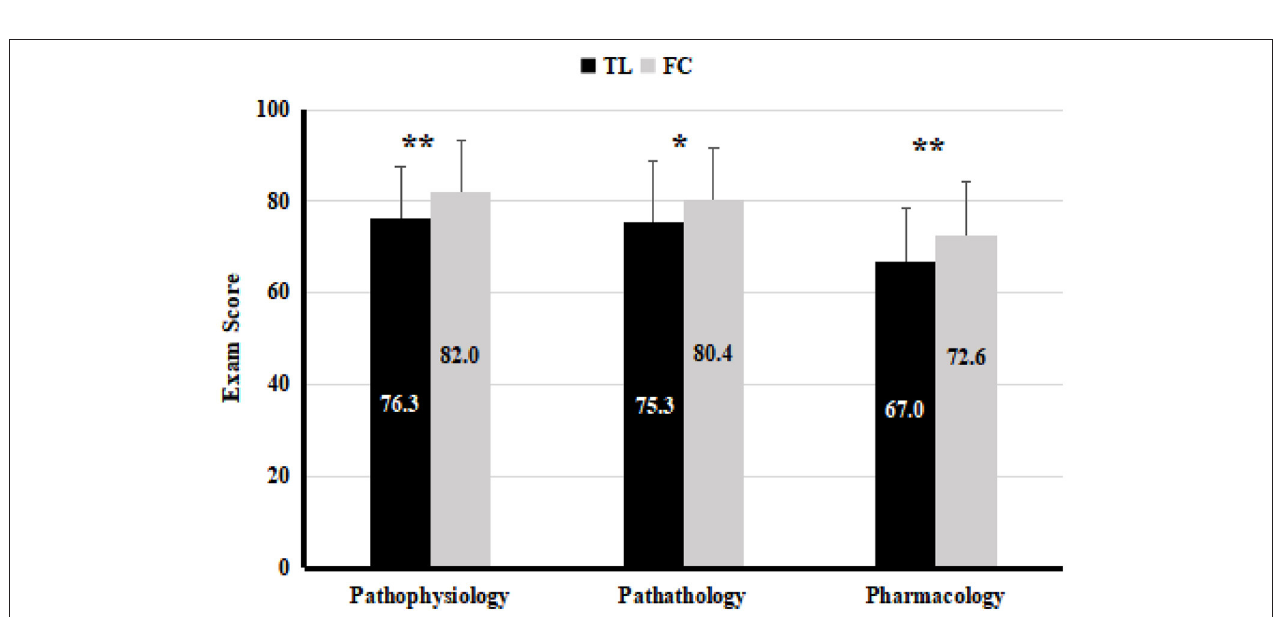
internal medicine ( P < 0.001) were significantly higher in the experimental group than in the control group. The scores for surgery pandect were however not significantly different between the two groups ( P > 0.05). Our suggested that FC teaching had a long-term positive effect on the students’ learning effectiveness in the courses conducted after the completion of FC